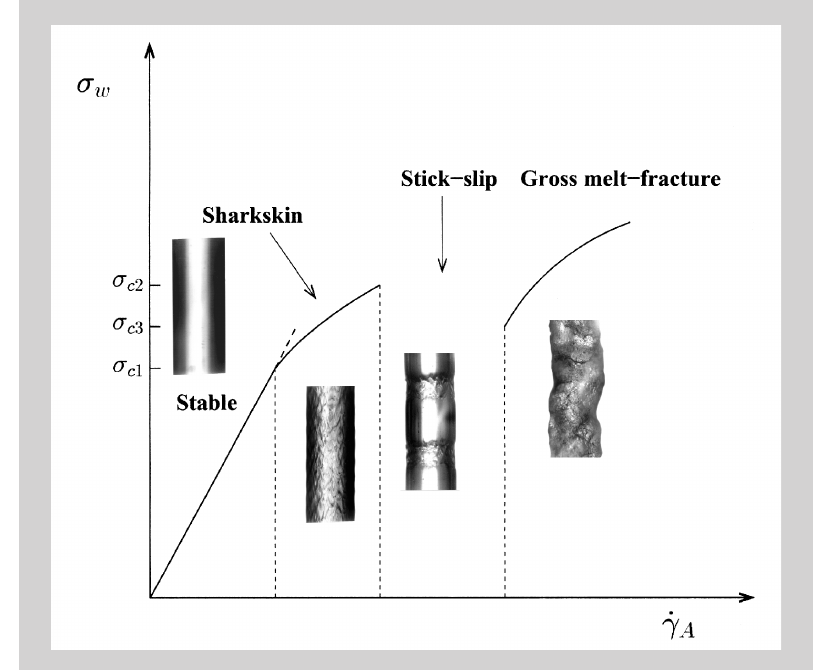
Figure 1: Typical flow curve for a linear polyethylene and regions of